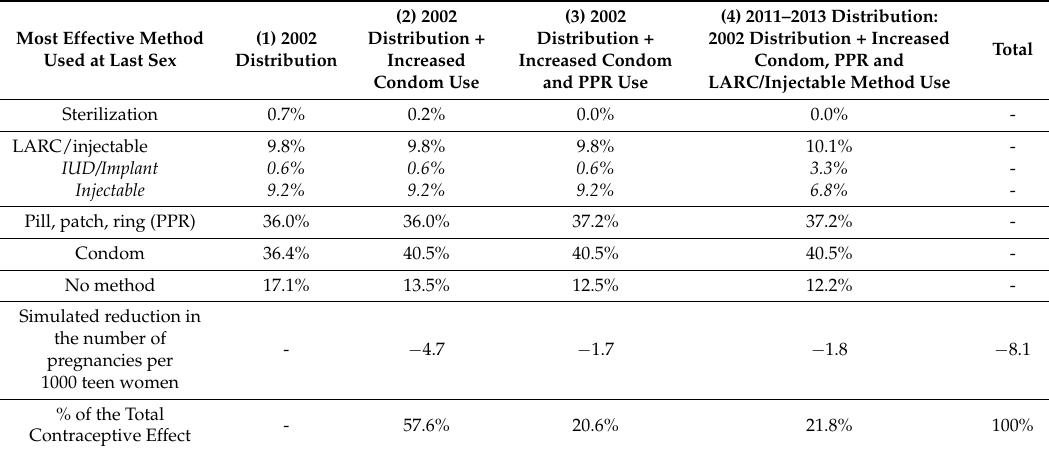
Table 2. Decomposition of changes in teenage contraceptive use between 2002 and 2011–2013 and simulated effects on the teen pregnancy